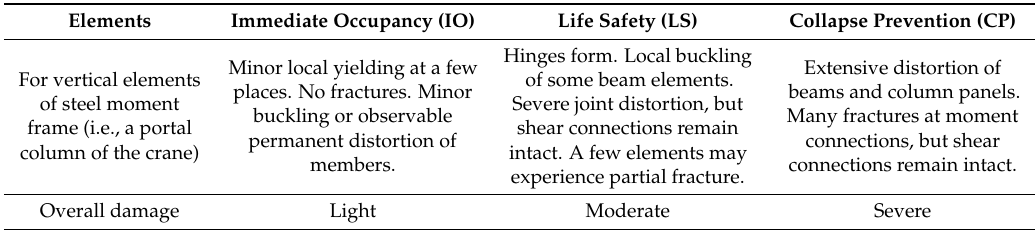
Figure 4. Pushover curve and limit states for the typical Korean container crane [11]. Table 1. Structural performance levels and damage [11].